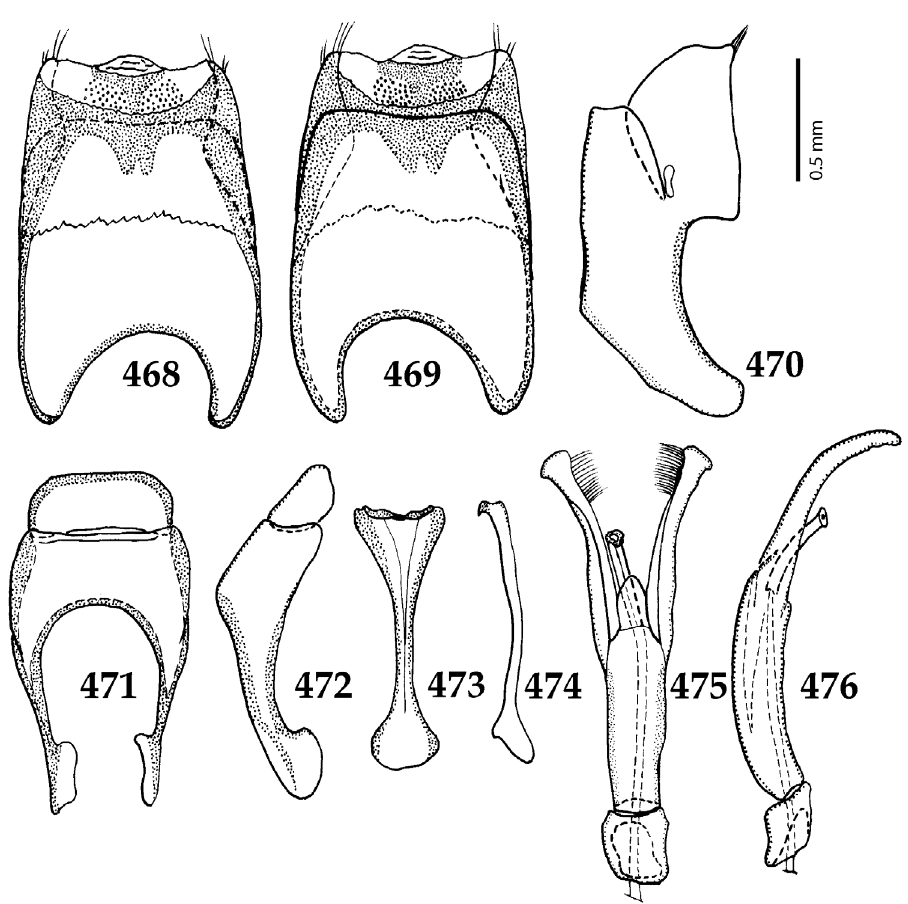
tergite, ventral view 469 ditto, dorsal view 470 ditto, lateral view 471 male terminalia: 9 th + 10 th tergites, dorsal view 472 ditto, lateral view 473 male terminalia: spiculum gastrale, ventral view 474 ditto, lateral view 475 male terminalia: aedeagus, dorsal view 476 ditto, lateral